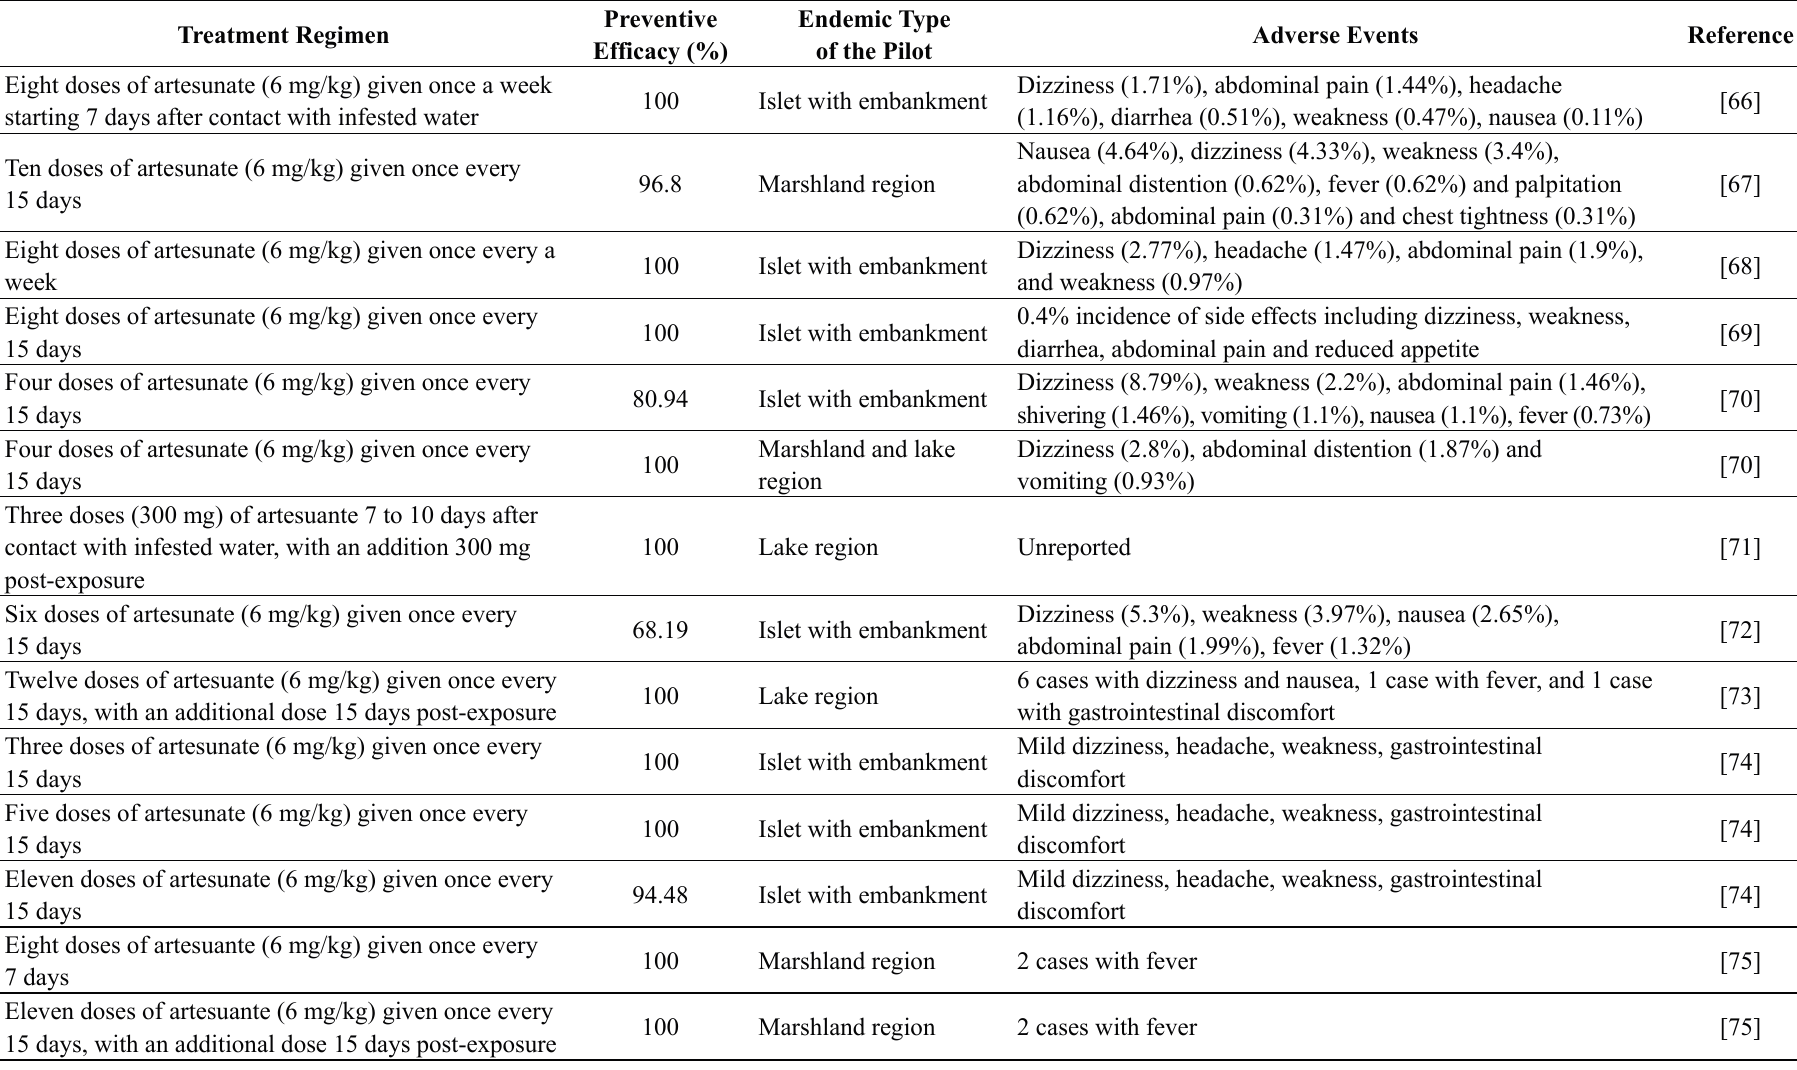
Table 2. Clinical trials conducted to test the preventive efficacy of artesunate against S. japonicum